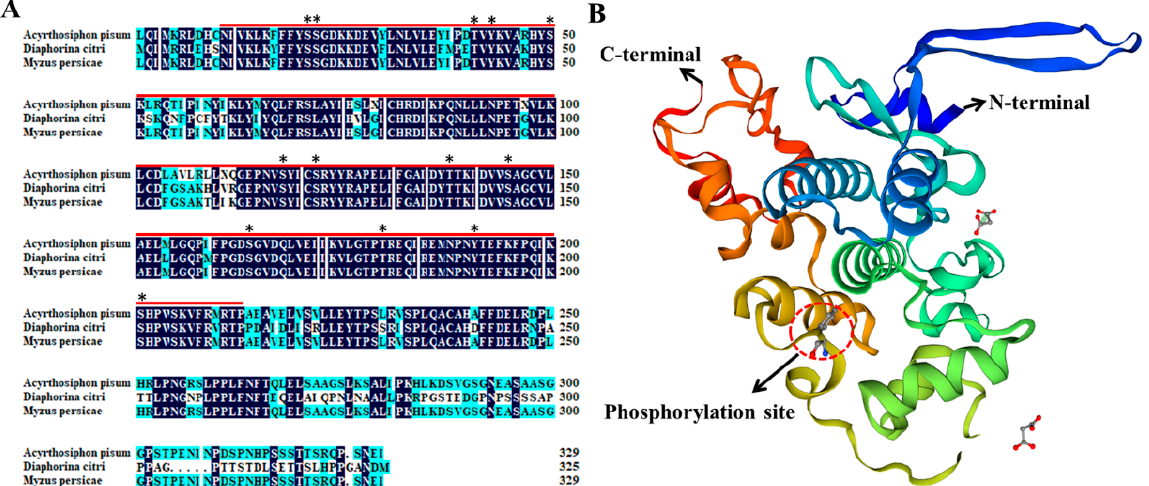
Figure 2. Multiple sequence alignment and protein structure analysis of DcGSK3. ( A ) Multiple sequence alignment of the GSK3 from three insect species, including Diaphorina citri , Acyrthosiphon pisum and Myzus persicae . The conserved amino acid residues are highlighted in blue, and similar amino acid residues were labeled in turquoise. The asterisk indicates the phosphorylation site. ( B ) Protein structure analysis of DcGSK3 by SWISS-MODEL software (Version 3.5, https://swissmodel.expasy.org/).